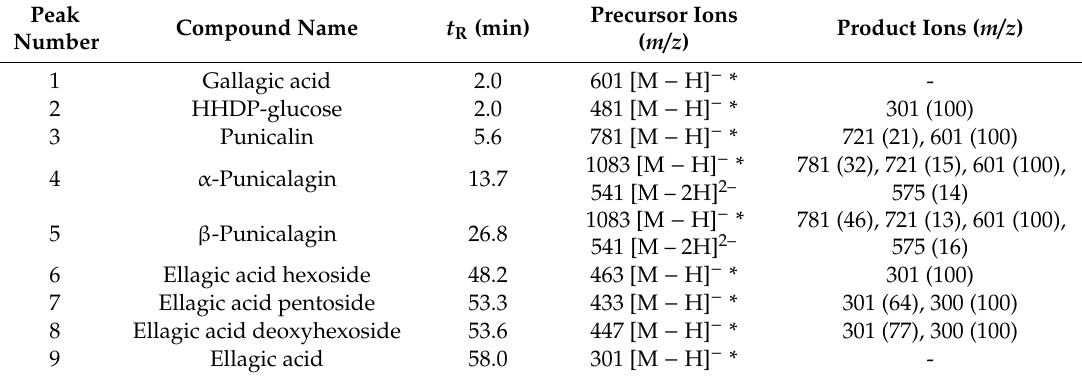
Table 2. Retention times and MS data of phenolic compounds detected in pomegranate rind. Experimental conditions as in Materials and Methods section. The MS 2 data were obtained from the fragmentation of the precursor ion marked with an asterisk. Relative intensities of product ions are in